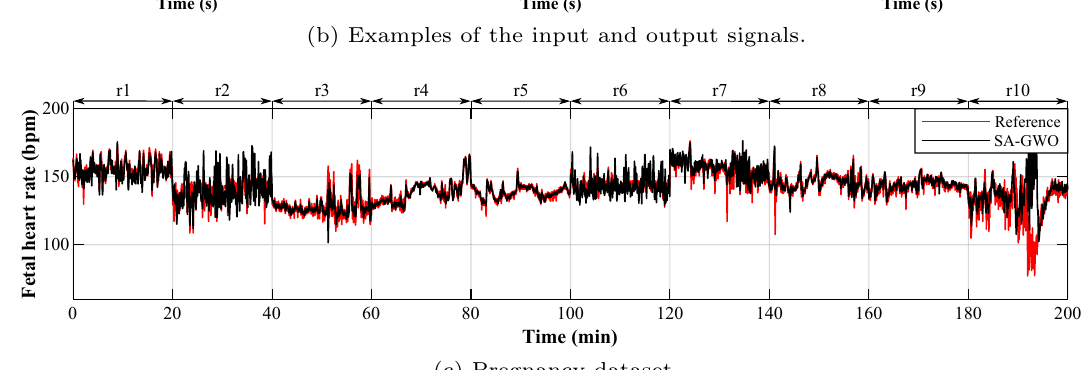
Figure 4. Comparison of fHR traces determined from signals extracted with the SA-GWO method and reference fHR trace for all recordings and the examples of the signals from selected records: ( a ) the fHR trace determined from the Labour dataset records using the fECG signal extracted by the SA-GWO system (black) in comparison with the reference fHR trace (red); ( b ) examples of the extracted signals from records achieving low (r3, r10) and high (r5) quality results along with the obtained parameters and illustration of TP and FP values; ( c ) the fHR trace determined from the Pregnancy dataset records using the fECG signal extracted by the SA-GWO system (black) in comparison with the reference fHR trace